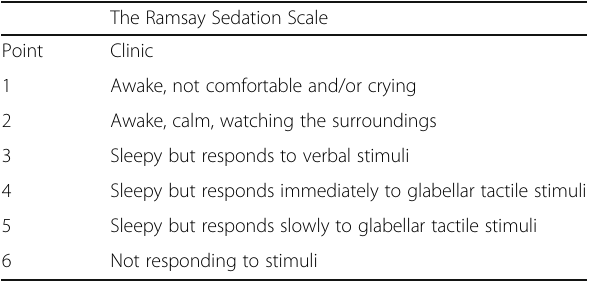
Table 2 Ramsay Sedation Scale